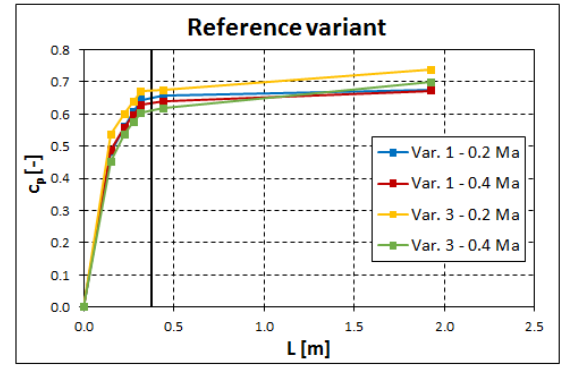
Fig. 12. Dependence 𝑐 𝑝 on 𝐿 – reference variant.